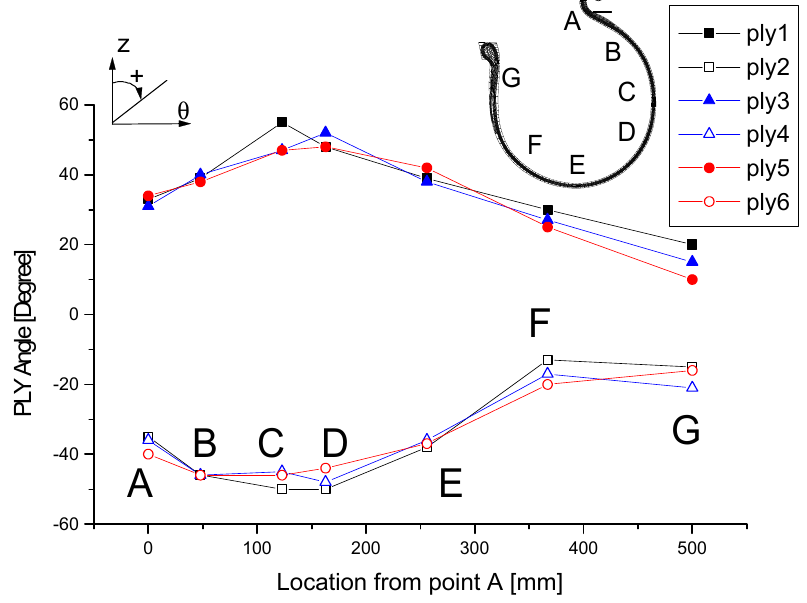
Figure 1. Measured cord angles of the 684N diaphragm-type air spring at the designated points from the reference [5].